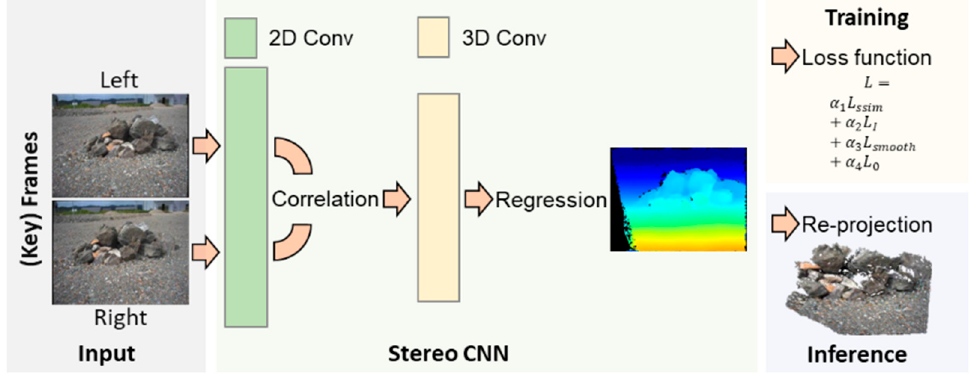
Figure 4. Self-supervised stereo CNN for dense point-cloud mapping .